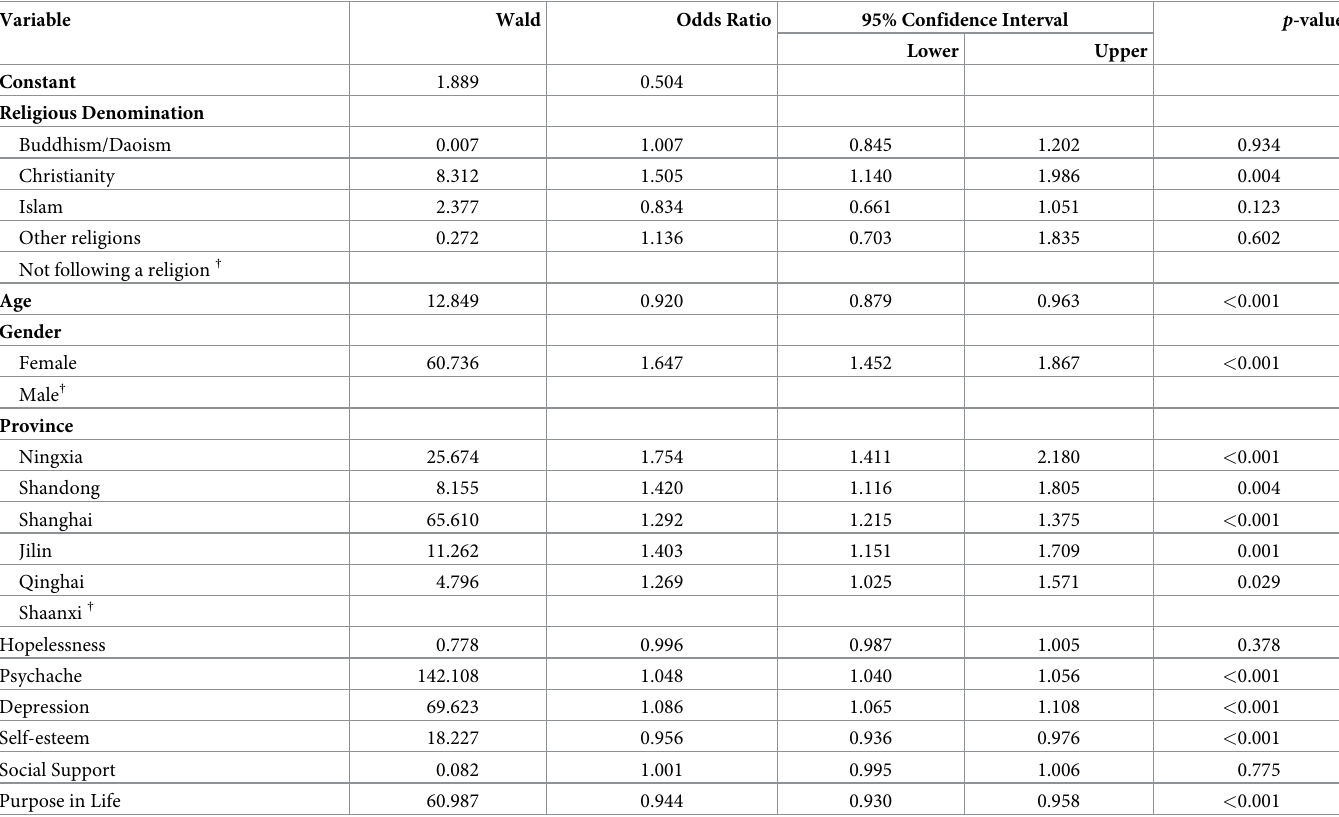
Table 4. Multiple logistic regression analysis for factors predicting suicide risk (based on a total score of 7 and above on the Suicidal Behaviors Questionnaire- Revised) among college students.